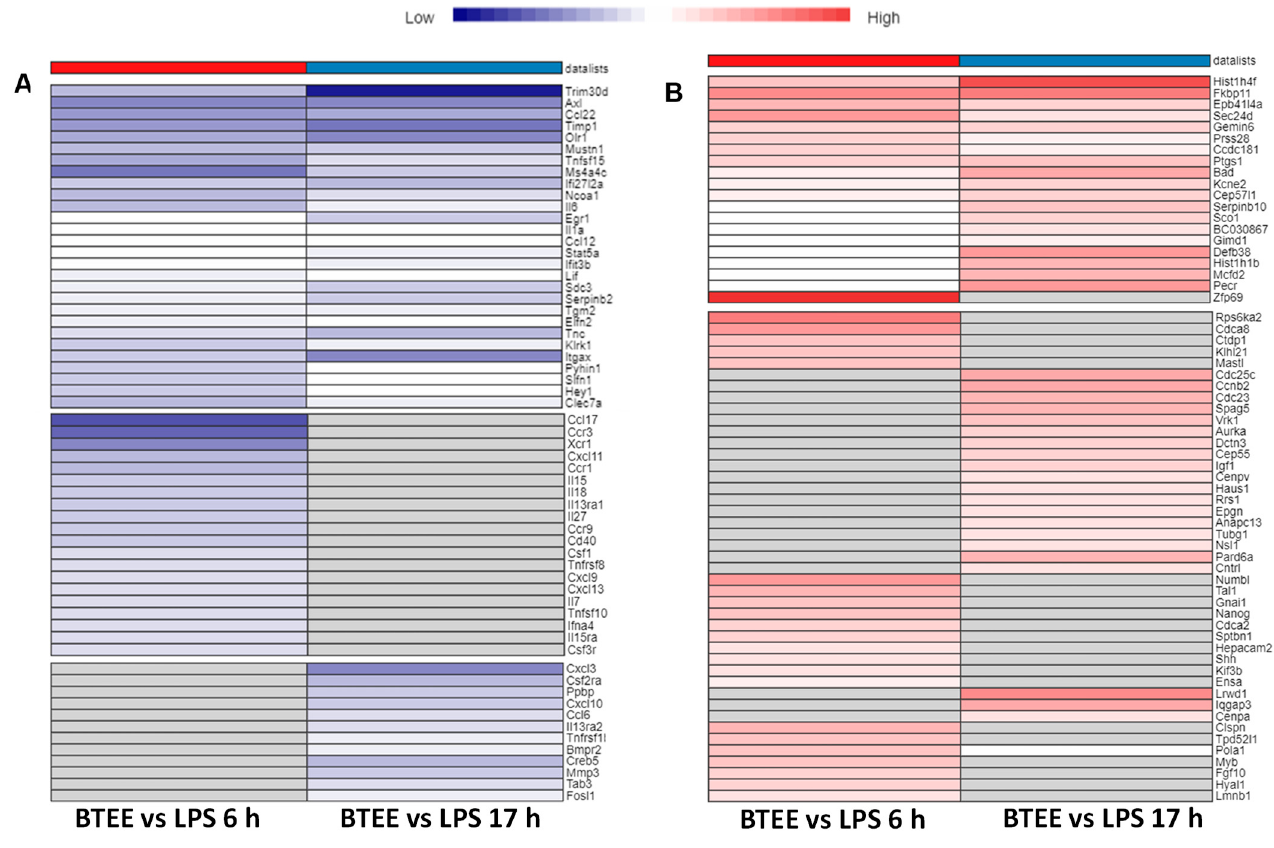
Figure 8. Heatmaps of DEGs of top enriched functions. ( A ) Expression profile of downregulated DEGs associated with several inflammatory pathways; ( B ) Expression profile of upregulated DEGs associated with cell cycle and cell division.